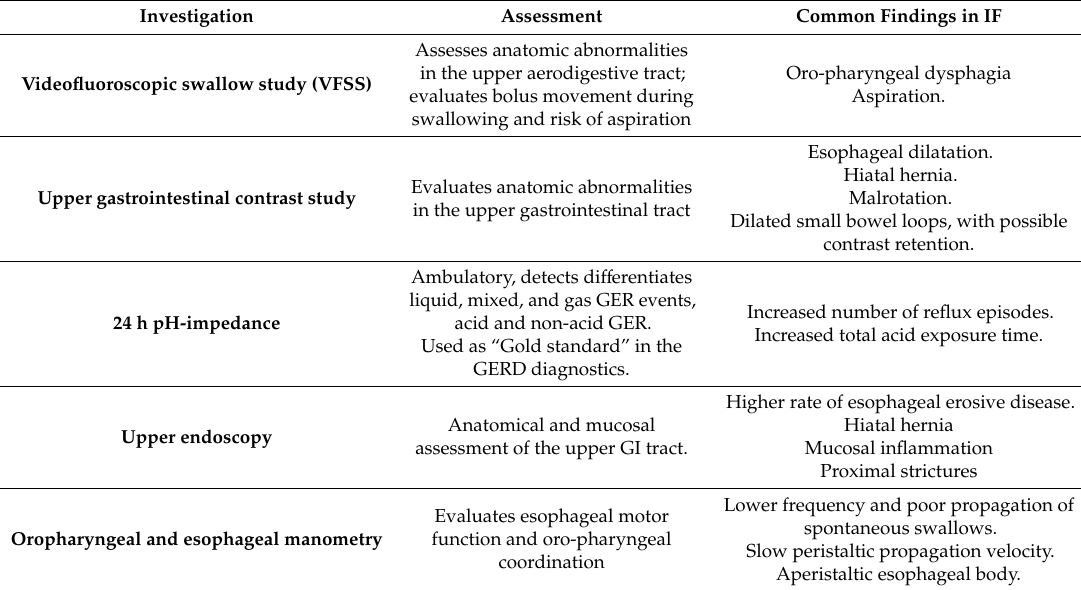
Table 3. Diagnostic tools in foregut